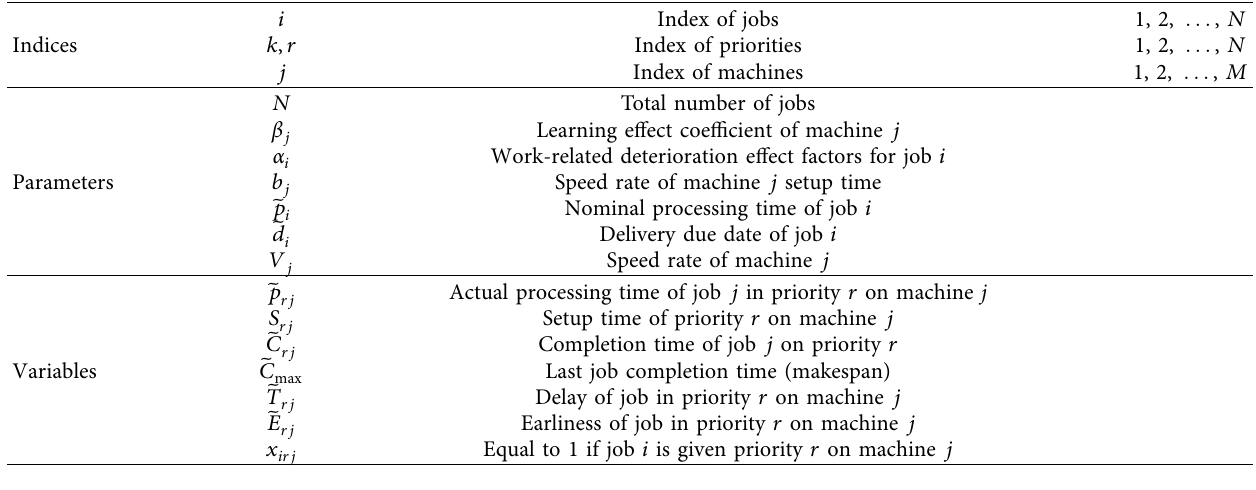
Table 1: MOMINLP decision parameters and